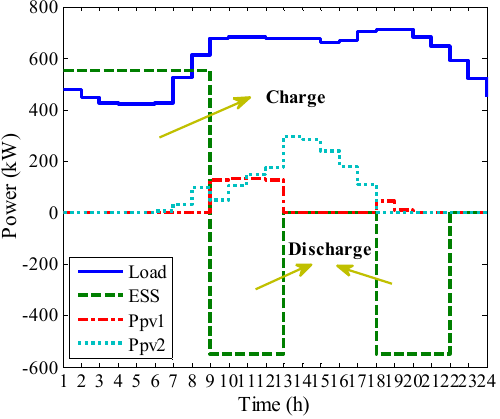
Figure 6. The operated curves when the power and capacity are 550 kW and 4400 kWh, respectively.